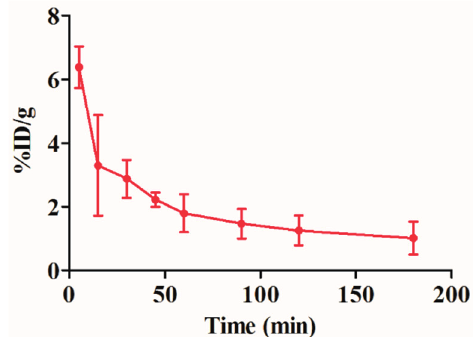
Figure 5. Blood clearance of the 99m Tc-RGD4C β L. Three Wistar rats were injected with